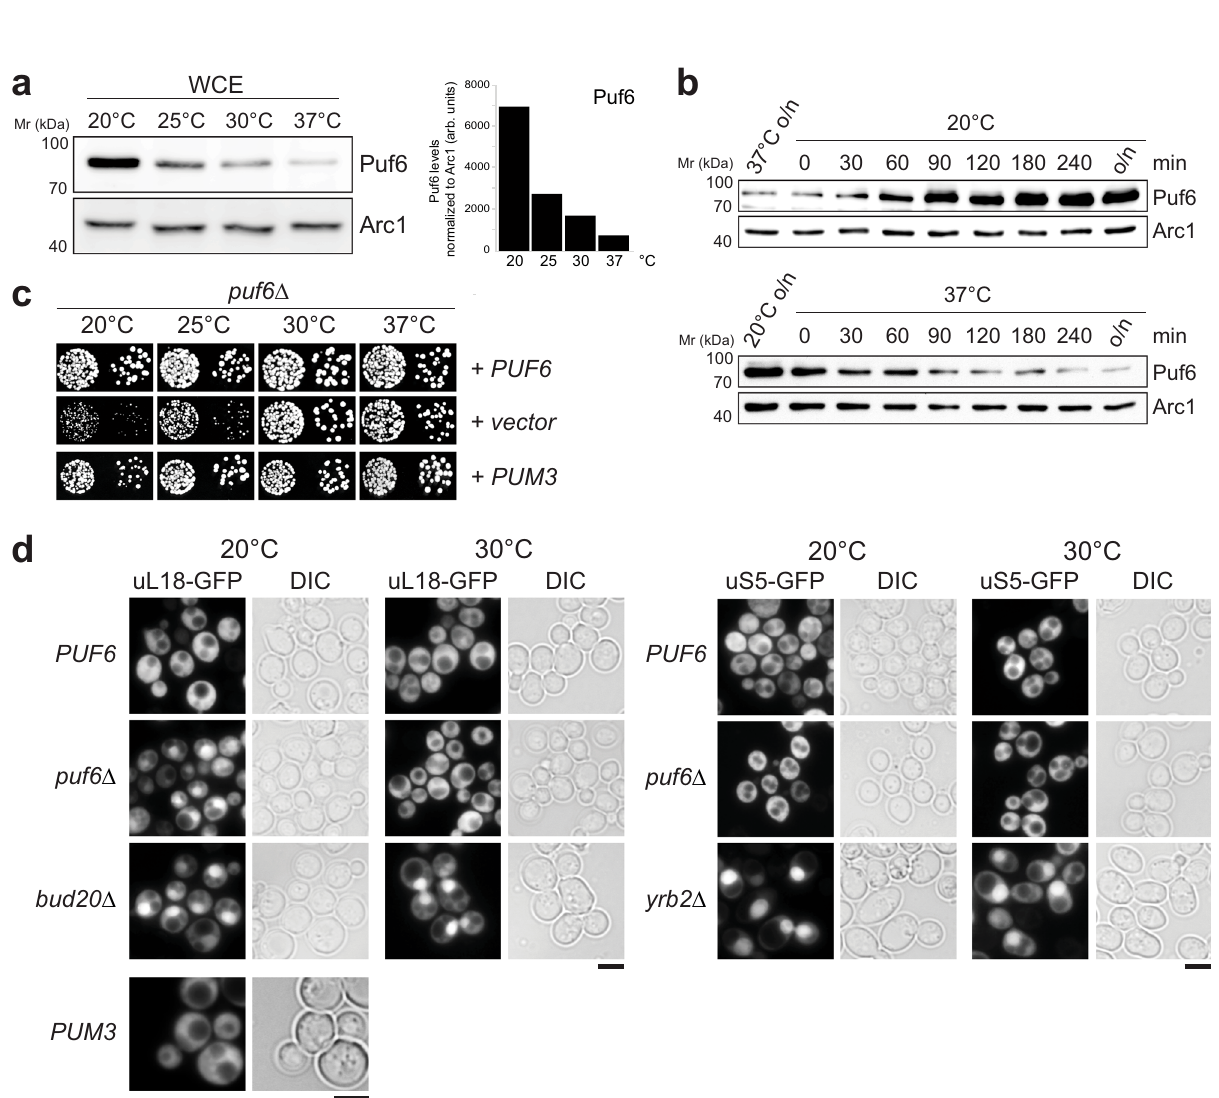
Fig. 1 Quantifying alterations in the proteome by SWATH-MS in yeast cells grown at different temperatures. a Experimental work fl ow for SWATH-MS characterization of proteomes of yeast cells grown at 20, 25, 30, and 37 °C. Whole-cell extracts derived from WT yeast cells grown at indicated temperatures were subjected to the SWATH-MS and hierarchical clustering of proteins based on their abundance pro fi le at different temperatures was performed. b Hierarchical clustering pro fi les of protein levels at the indicated temperatures. c Relative enrichment of ribosome assembly factors and ribosomal proteins from clusters 1, 2, and 4. Maximum enrichment is depicted in purple and minimum enrichment in gold. Proteins were further grouped based on their GO annotations — according to the indicated color code. Signi fi cance of the protein change was assessed using a one-way ANOVA test, with the resulting p -value further adjusted using the FDR method; ***adj.p.value < 0.0001; **adj.p.value < 0.001; *adj.p.value < 0.01; – adj.p.value ≥ 0.01.